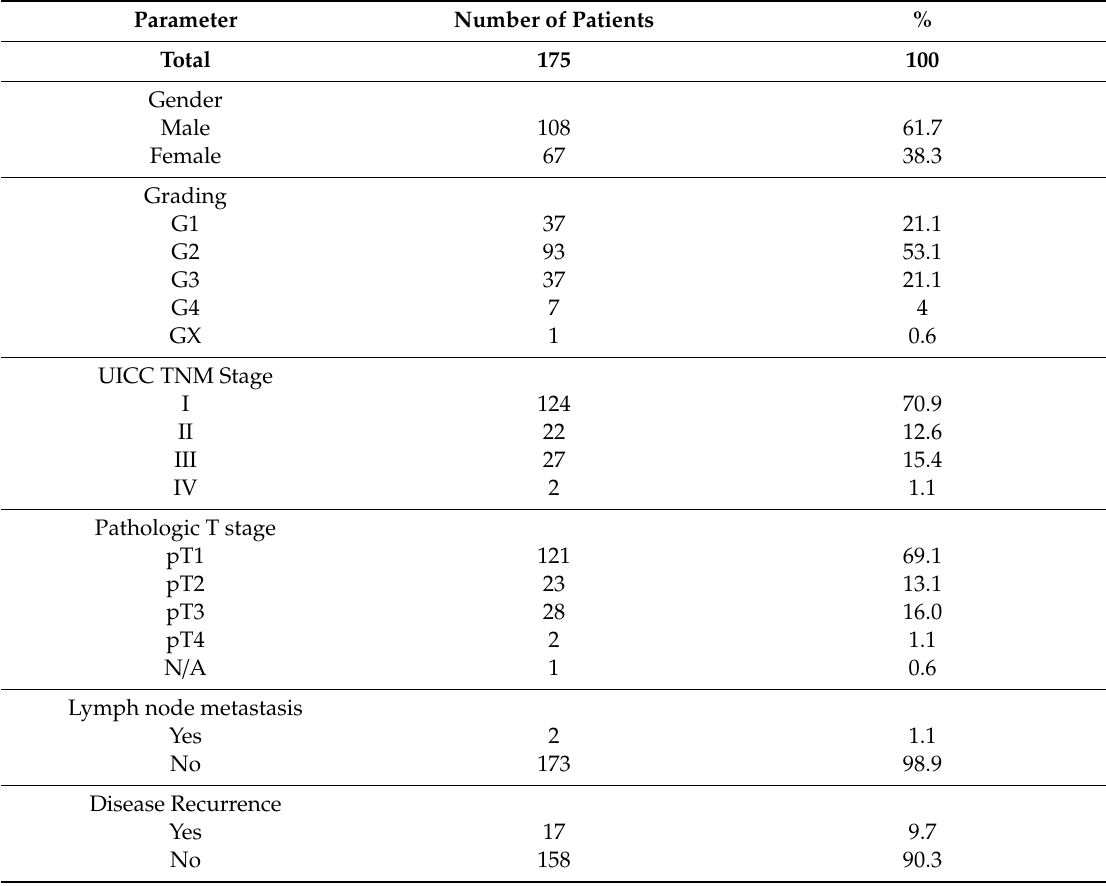
Table 1. Clinicopathological parameters of ccRCC patients in the study cohort ( n = 175). Parameter Number of